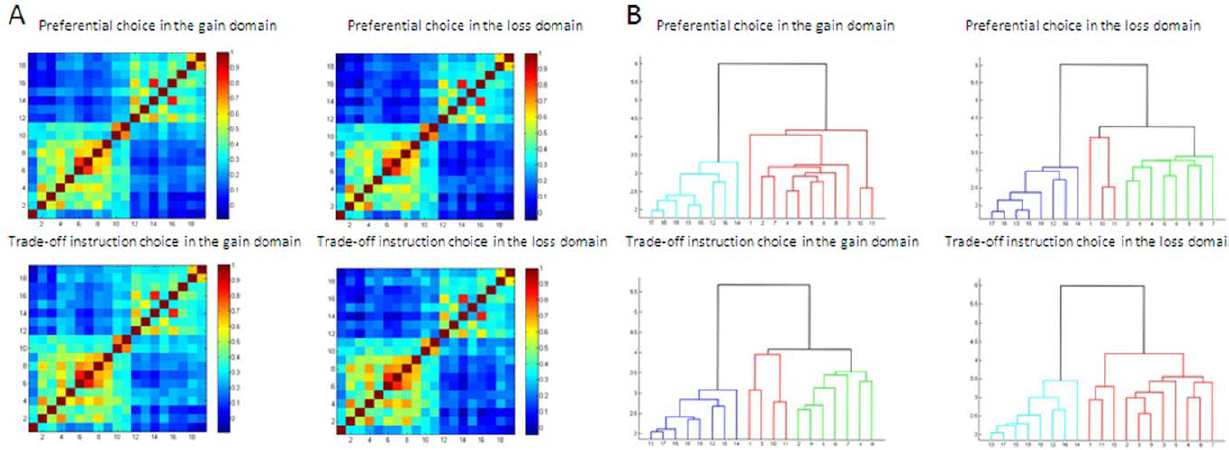
Figure 3. The mean r-value matrices (A) and hierarchical clustering analyses (B) for the four task conditions: the preferential choice in the gain domain, the preferential choice in the loss domain, the trade-off instruction choice in the gain domain and the trade-off instruction choice in the loss domain. (A): Each figure shows a 19 6 19 square matrix in which the x and y axes correspond to the regions listed in Table 1 and in which each entry indicates the mean strength of the functional connectivity between each pair of brain regions. The z score of the functional connectivity is indicated with a colored bar. (B): The vertical axis represents distance. The numbers in the horizontal axis represent the seed regions. Please see Table 1 for a detailed interpretation of the numbers.